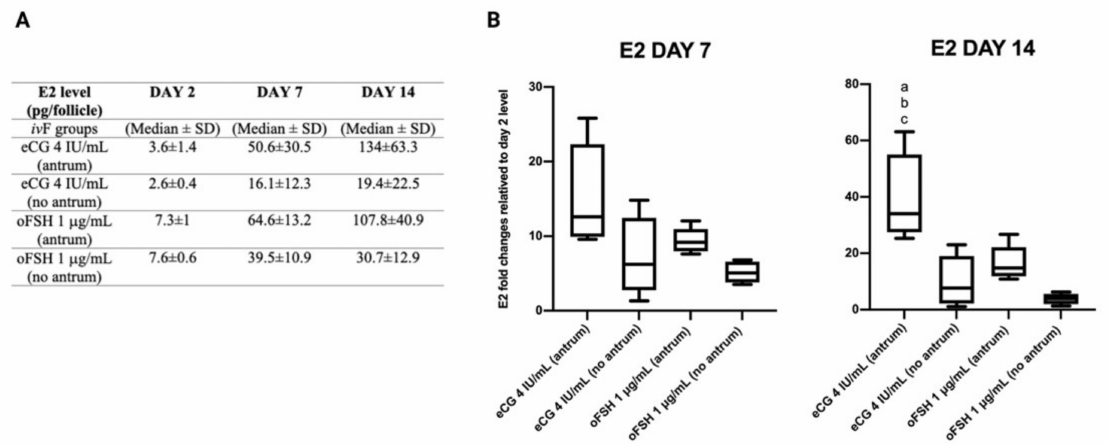
Figure 7. Table reporting median levels of E2 (pg/follicle) detected in conditioned follicular media in the different iv F culture conditions at Days 2, 7, and 14 ( A ). Data box-plot of estradiol concentrations in different follicular treatment groups during the culture period. Values of estradiol concentrations on day 7 and 14 were compared to the value on day 2 (first controlled point during the culture period) to evaluate dynamic of estradiol production. Letters indicate significant differences between a eCG 4 IU/mL (antrum) vs. eCG 4 IU/mL (no antrum); b eCG 4 IU/mL (antrum) vs. oFSH 1 µ g/mL (antrum); c eCG 4 IU/mL (antrum) vs. oFSH µ g/mL (no antrum) ( B ). Three independent biological replicates were performed. For each biological replicate, 66, 67, and 67 follicles per group (eCG 4 IU/mL and oFSH 1 µ g/mL) were cultured and tested for this